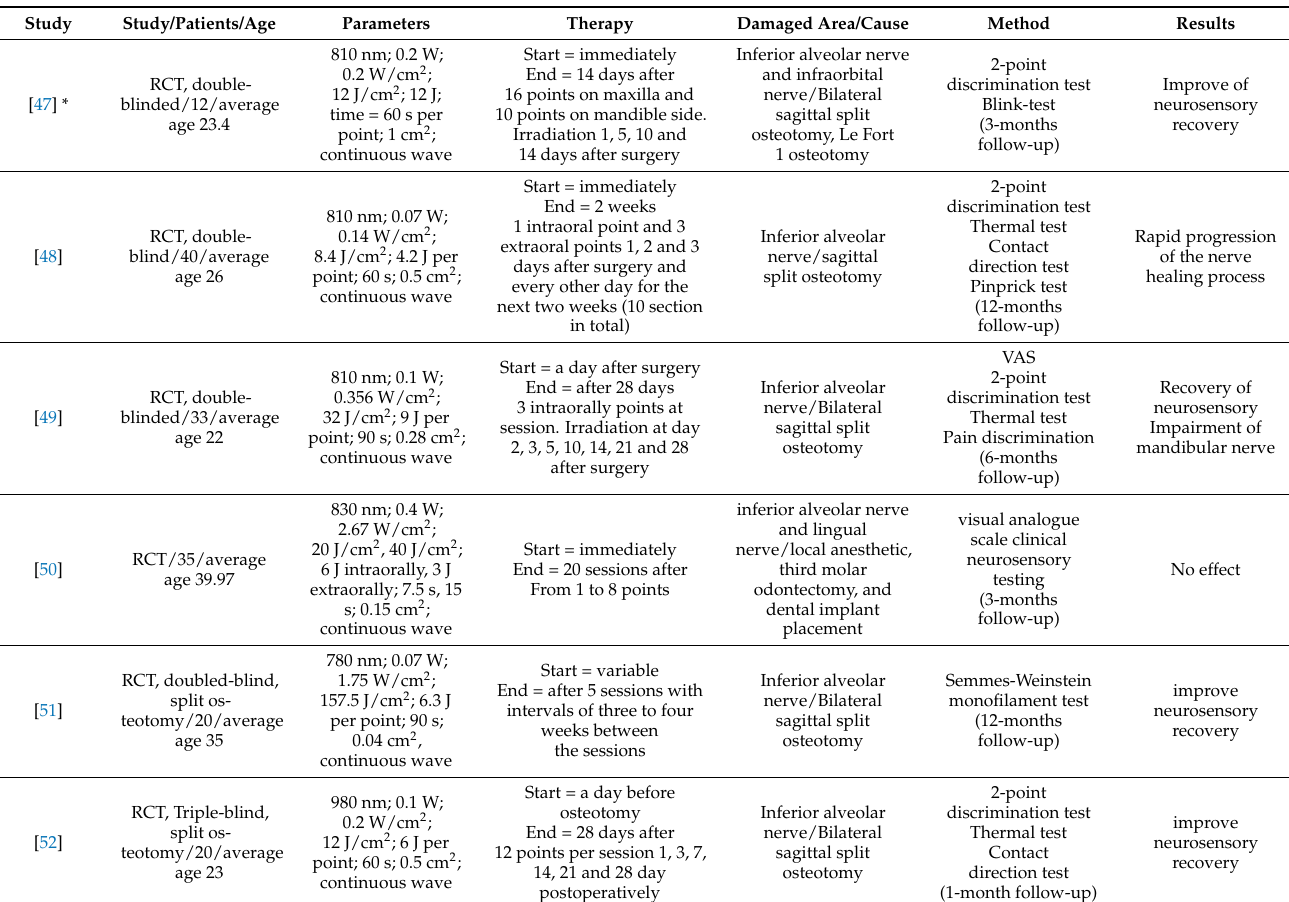
Table 2. Included randomised control trial (RCT) studies. Clinical studies on photobiomodulation and trigeminal branches nerves recovery selected after the inclusion and exclusion criteria and PRISMA, COCHRANE guideline screening. Study Study/Patients/Age Parameters Method